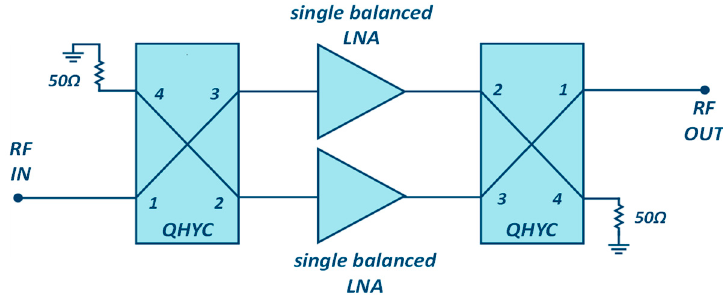
Figure 9. Balanced LNA schematic.